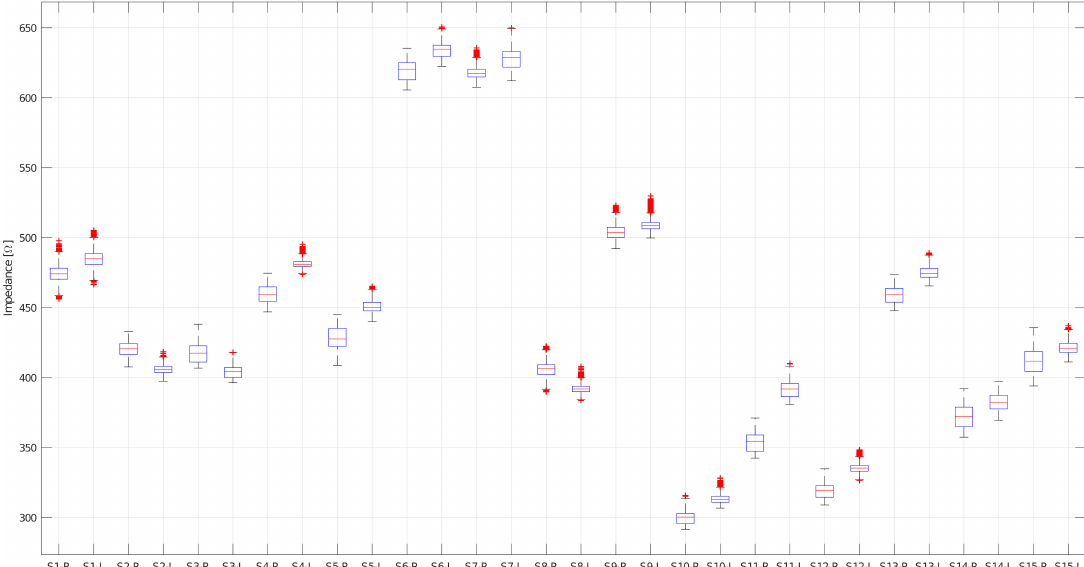
Figure 12. Distribution of raw TEBs for left (L) and right (R) hemithorax of all 15 subjects [36].